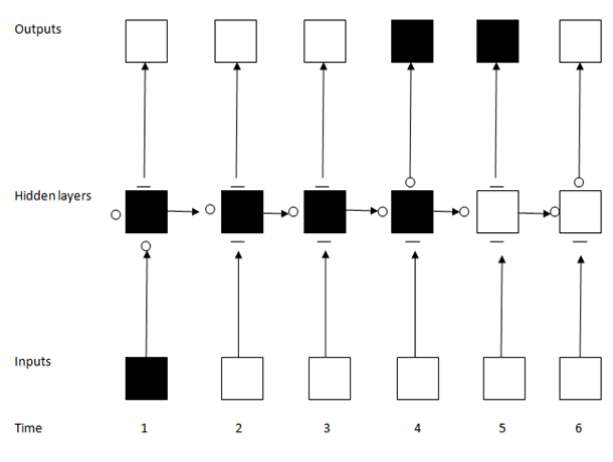
Figure 4. Working of LSTM gates